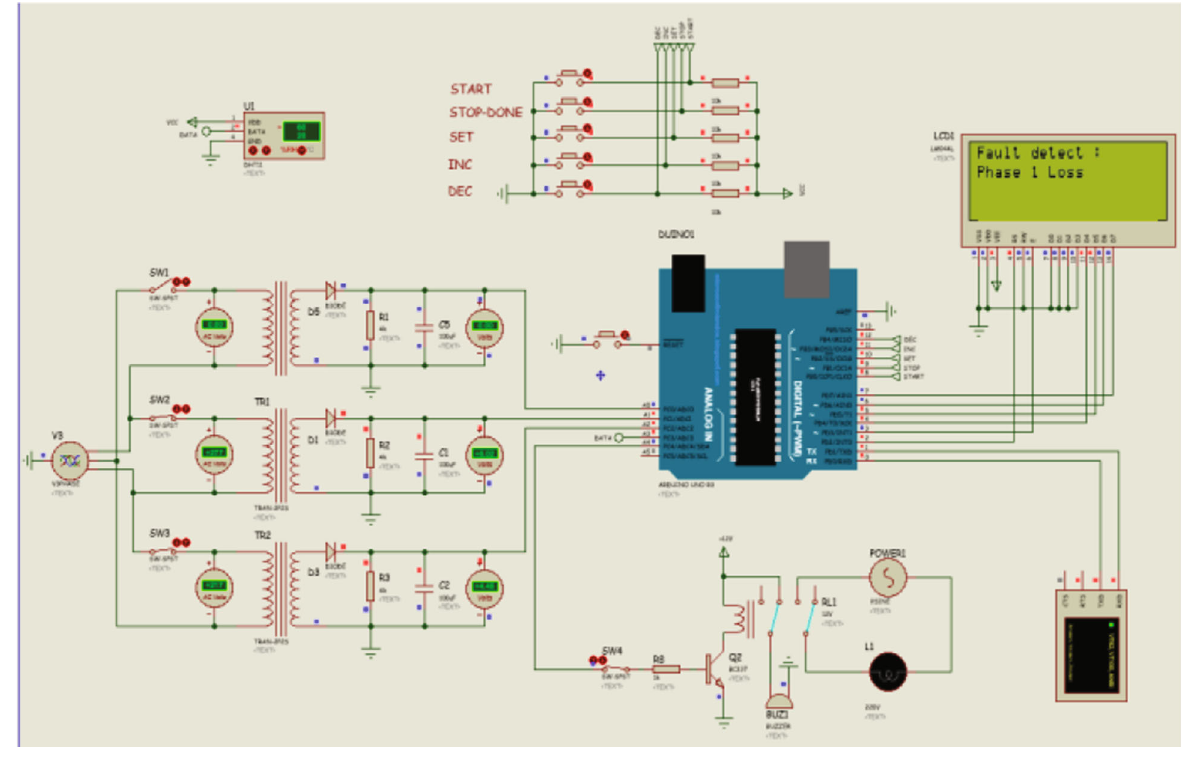
Figure 4: Single phasing